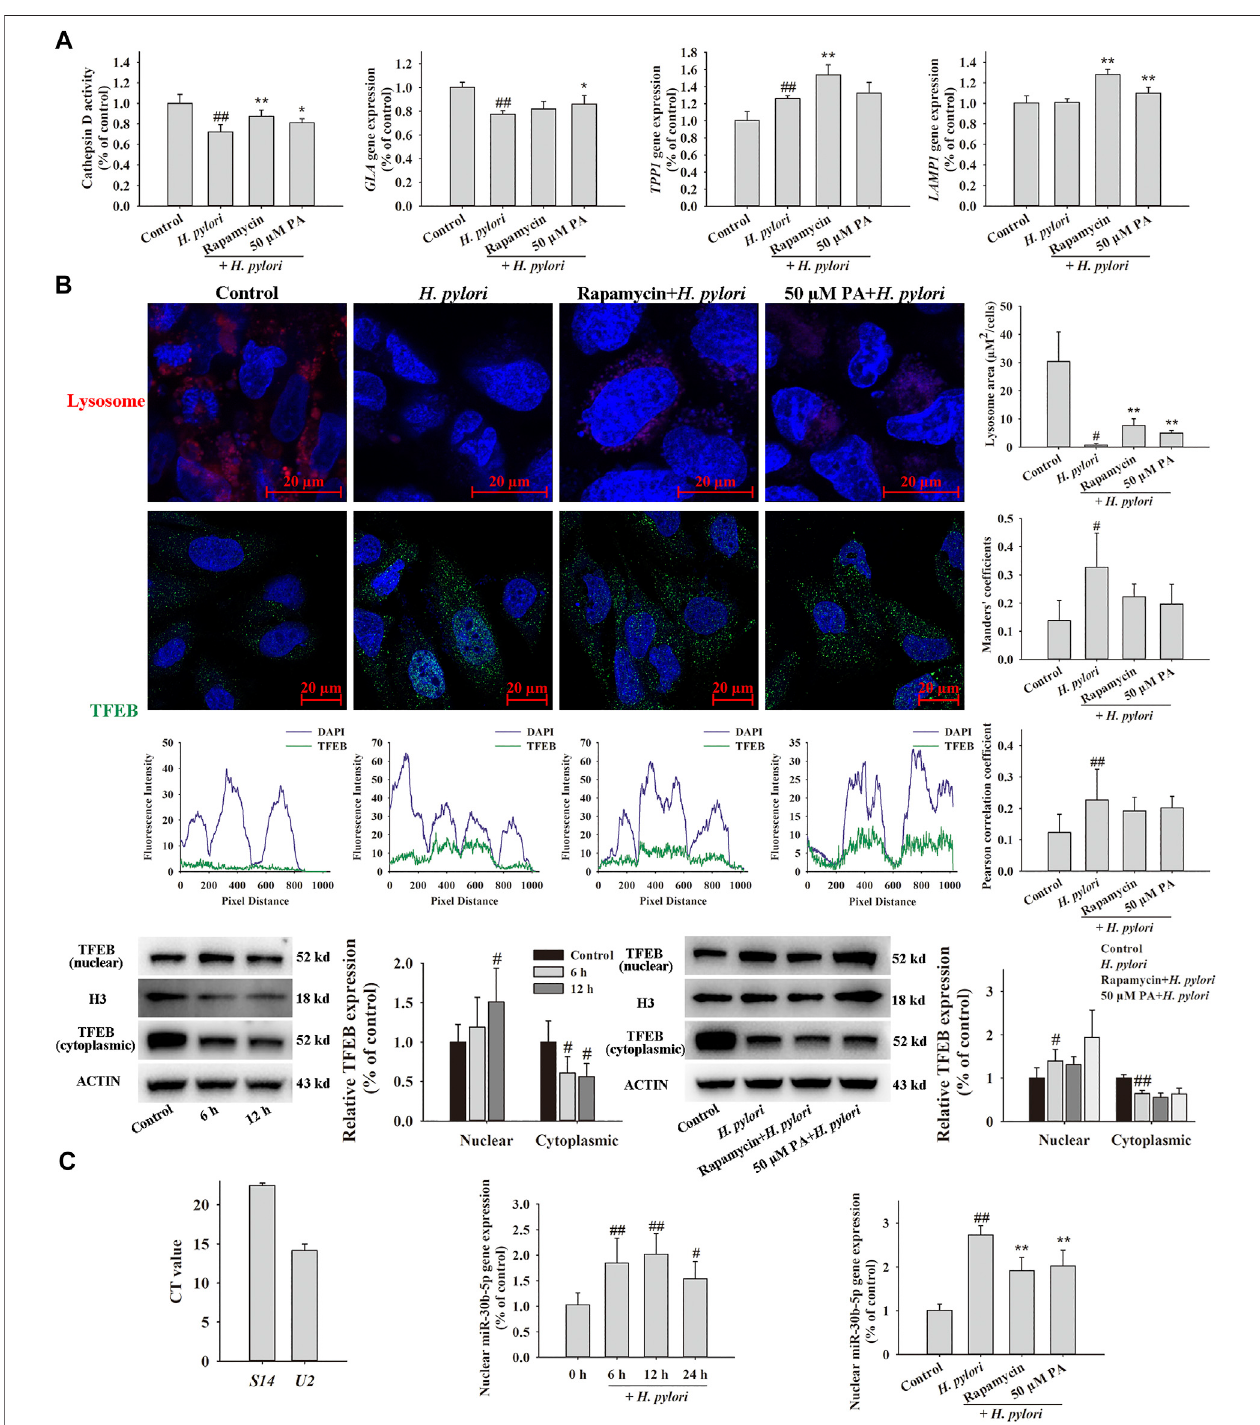
FIGURE 8 | Effects of PA on lysosome function. GES-1 cells were pretreated with rapamycin or PA for 12 h, infected with H. pylori for 12 h (except for the time- dependent assay), and then analyzed by qRT-PCR, Western blot, and immuno fl uorescence assays. (A) Effects of PA on H. pylori -induced lysosome activity, including cathepsinDactivity( n (cid:2) 8),representativelysosomegeneexpression,andrepresentativeimagesofLysoTrackerRedDND-99-labeledlysosome( n (cid:2) 5). (B) EffectsofPA on the lysosome mediator TFEB, including representative images of TFEB colocalized with nuclear DAPI and the corresponding quantitative data ( n (cid:2) 8), representative Western blots ( n (cid:2) 5), and quantitative data of nuclear and cytoplasmic TFEB. (C) Effects of PA on the nuclear transfection of miR-30b-5p, including con fi rmation of the successful isolation of nuclear RNA, time-dependent changes in nuclear miR-30b-5p expression, and downregulation of nuclear miR-30b-5p expression following PA treatment ( n (cid:2)